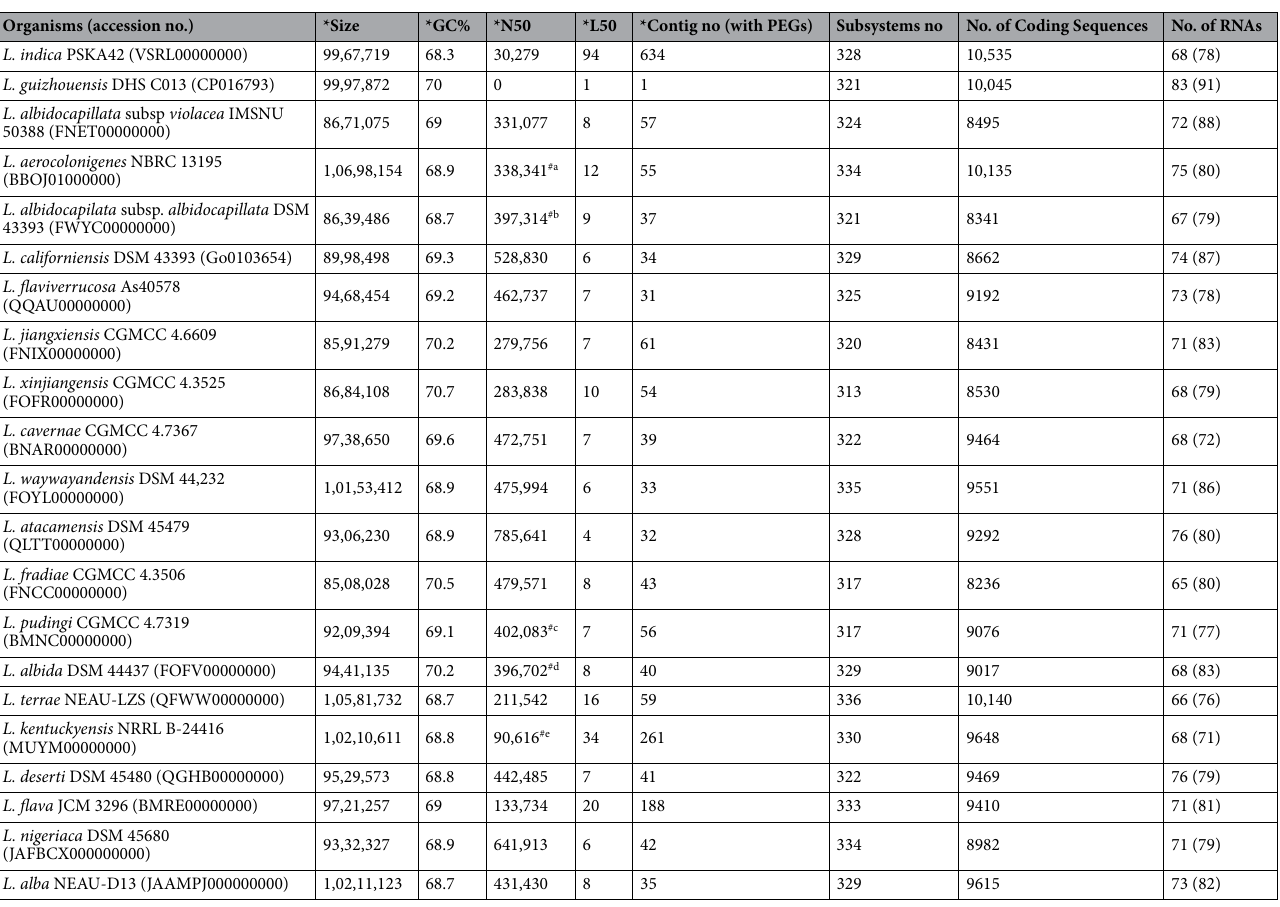
Table 1. Detailed characteristics of Lentzea genomes. *Both from PGAP and RAST, numbers in parentheses of last column indicates results obtained from PGAP annotation data from NCBI. # Difference in number between two annotation program. #a 348916. #b 397314. #c 432100. #d 352714. #e 92128.